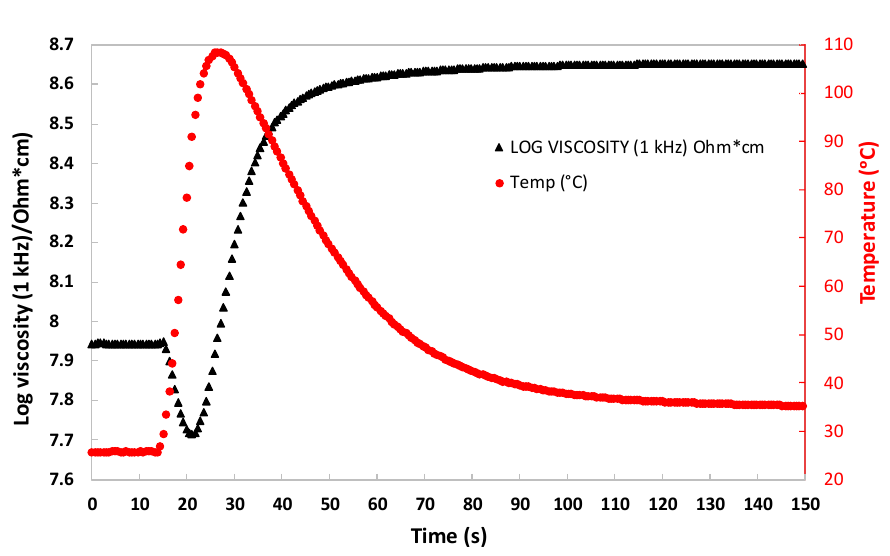
Figure 6. Loss factor ( ■ ) and temperature ( ● ) in the curing process, analysed by dielectric analysis (DEA) of the UV prepreg composed of 15 wt.% MAT225.